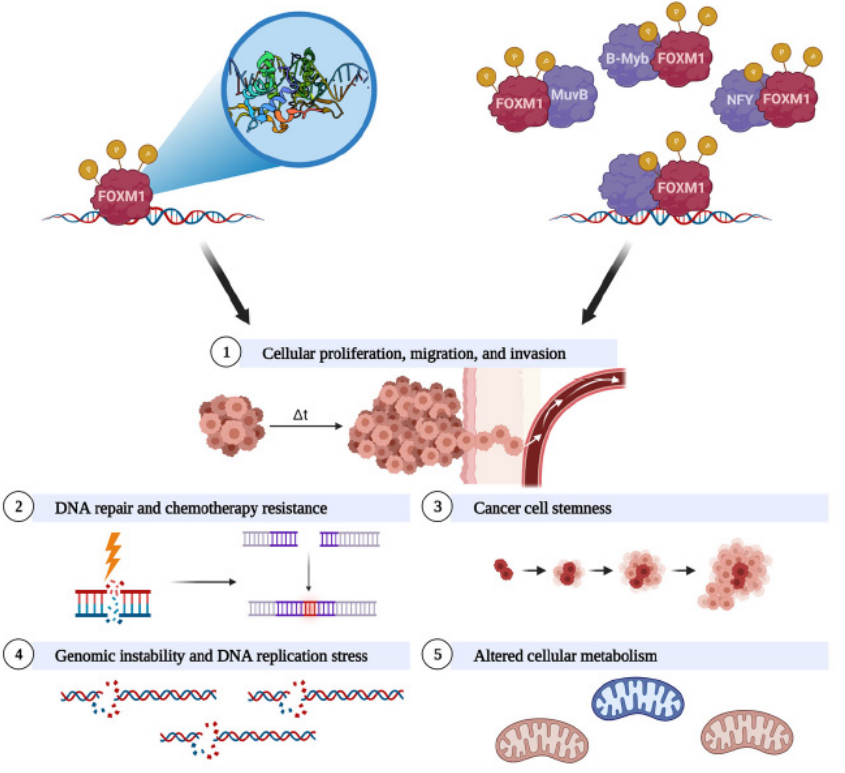
Figure 4. The oncogenic functions of FOXM1 in ovarian cancer. FOXM1 transactivates genes by binding to gene enhancers and promoters, either directly through its DNA binding domain (DBD) or indirectly by interacting with other transcription factors (B-Myb, MuvB, and NFY). Through these two mechanisms, FOXM1 has been shown to promote several oncogenic phenotypes in ovarian cancer, including: (1) cellular proliferation, migration, and invasion; (2) DNA repair and chemotherapy resistance; (3) cancer cell stemness; (4) genomic instability and DNA replication stress; (5) altered cellular metabolism. Figure created with BioRender.com. Table 2. FOXM1 target genes and their functions.